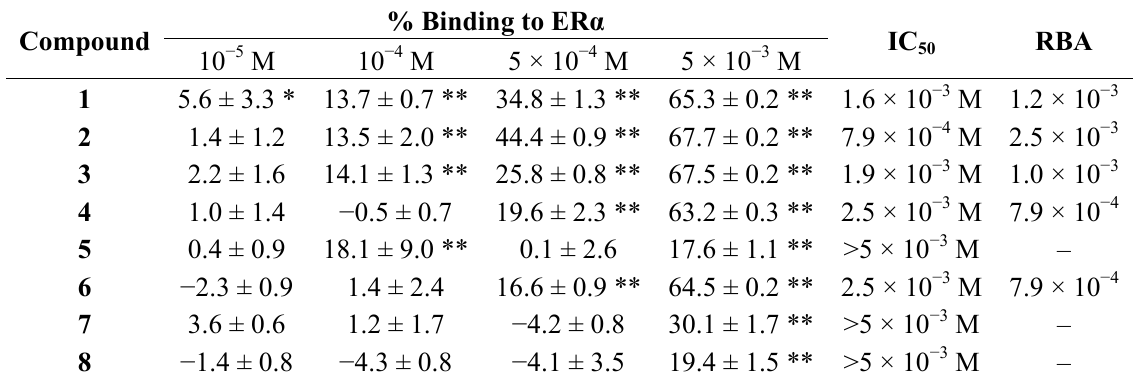
Table 1. Ligand binding affinities of arctigenin and its metabolites to ER alpha.